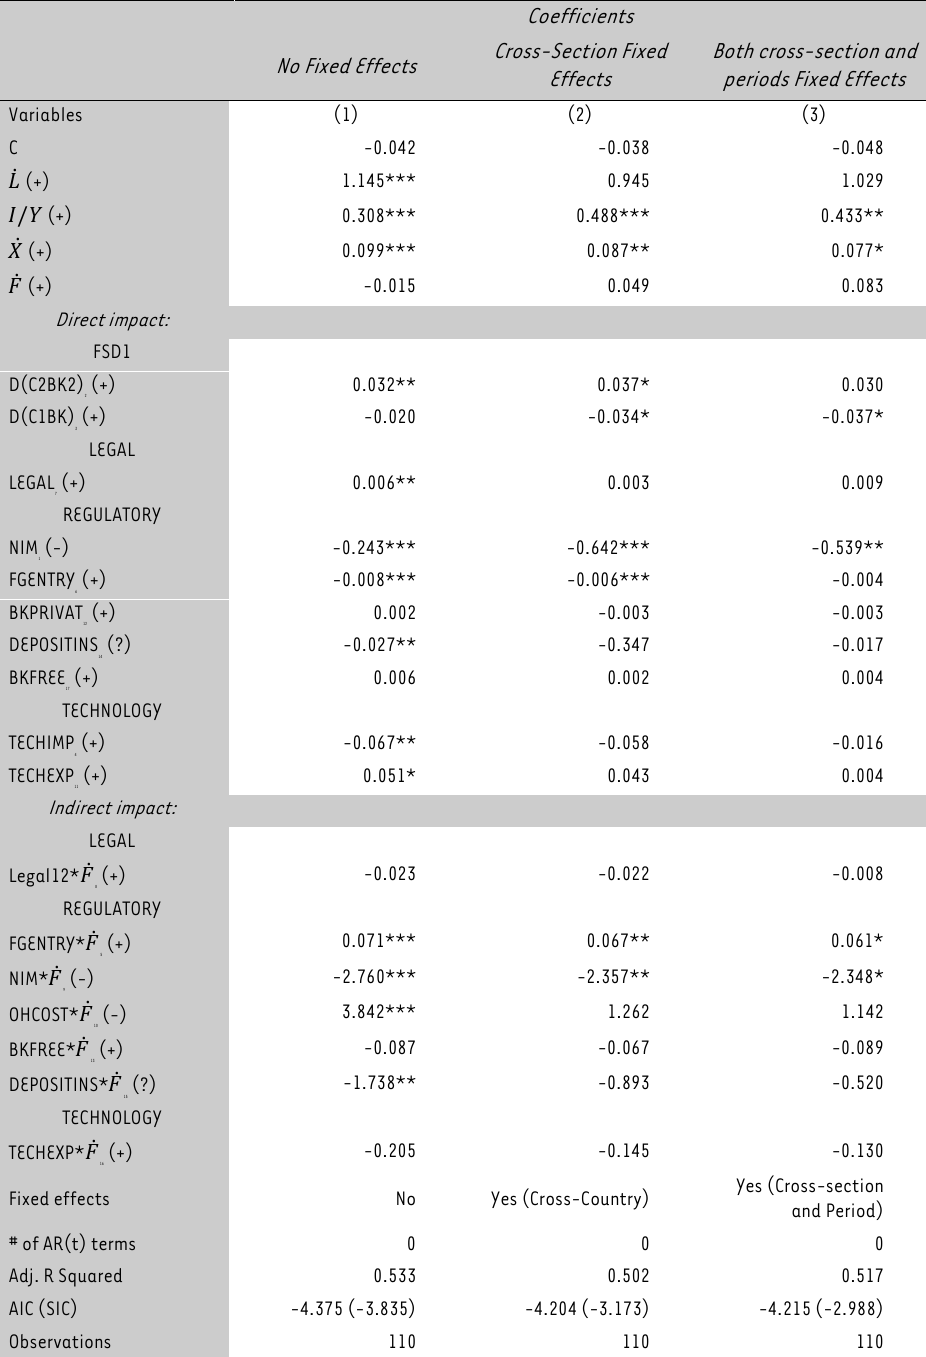
TABLE 7: Expanded panel regression results (direct and indirect effects with external